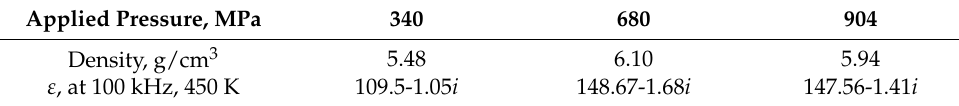
Table 2. Density of the samples as a function of the applied pressure. Applied Pressure,